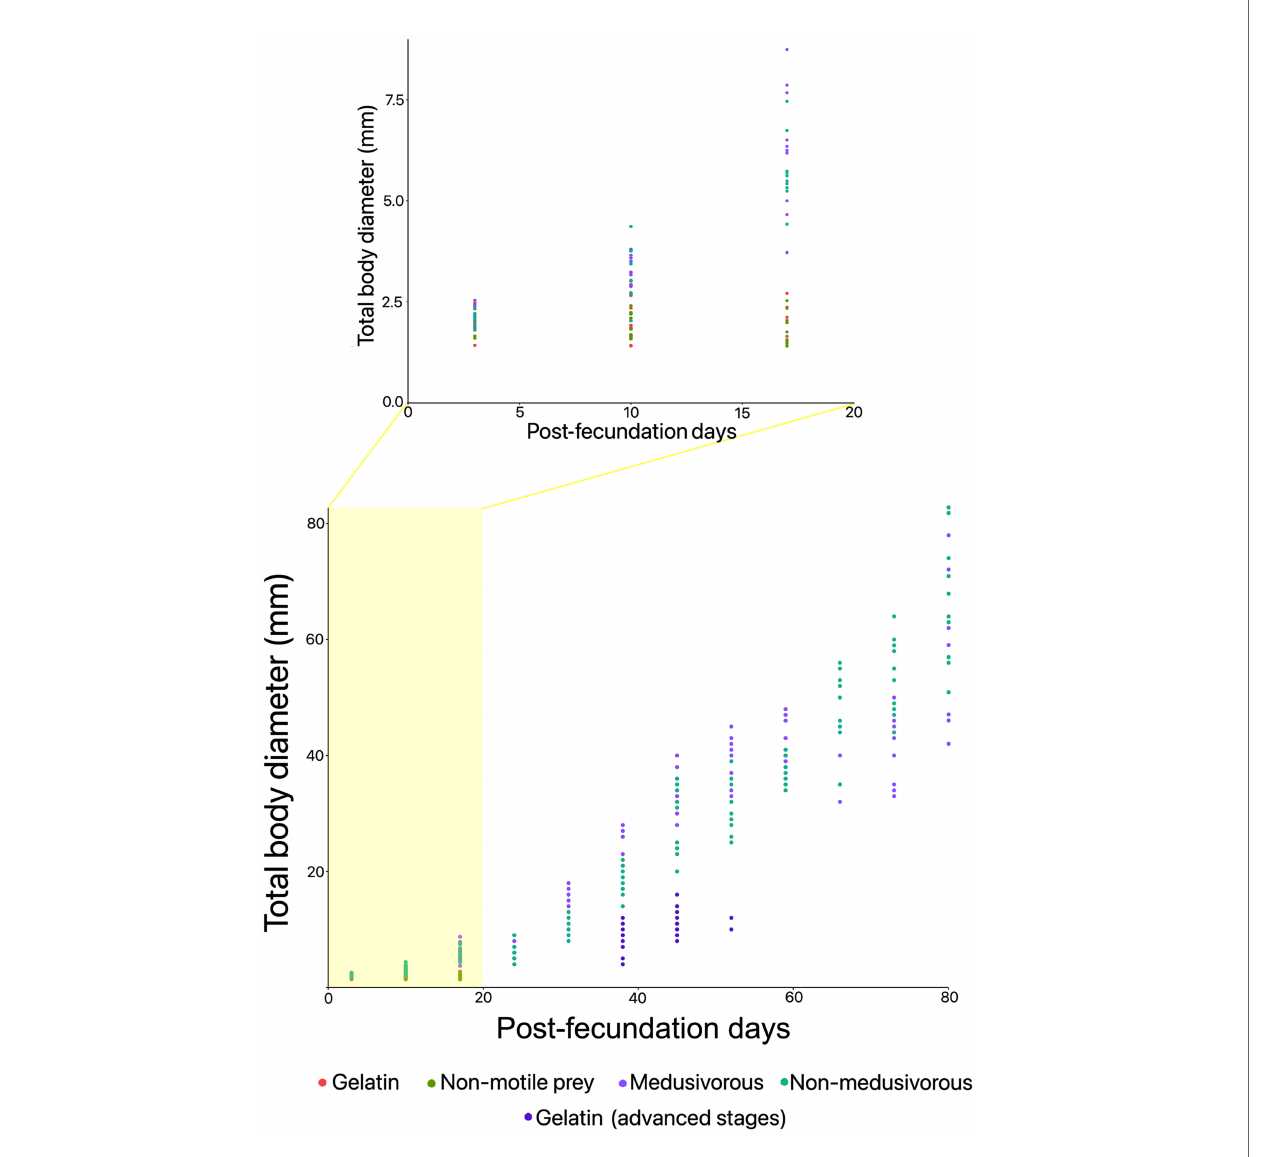
FIGURE 2 | Total body diameter over time in the presence of different food regimens for the fi rst generation of Pelagia noctiluca . Food regimens: Culture 1, encapsulated food in gelatin; Culture 2, non-motile prey; Culture 3, medusivorous diet (presence of Aurelia sp.); Culture 3.1, medusivorous diet during early stages and gelatin from advanced stages; and Culture 4, non-medusivorous diet (absence of Aurelia